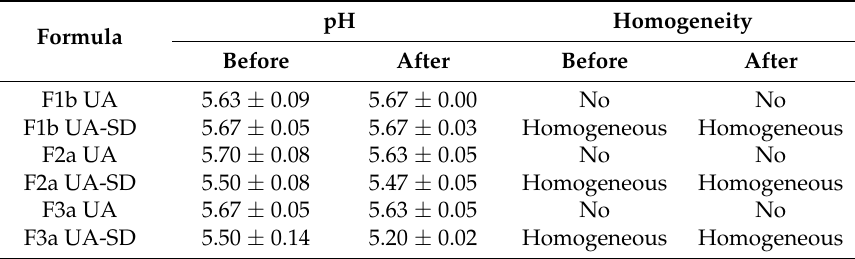
Table 5. Cycling test